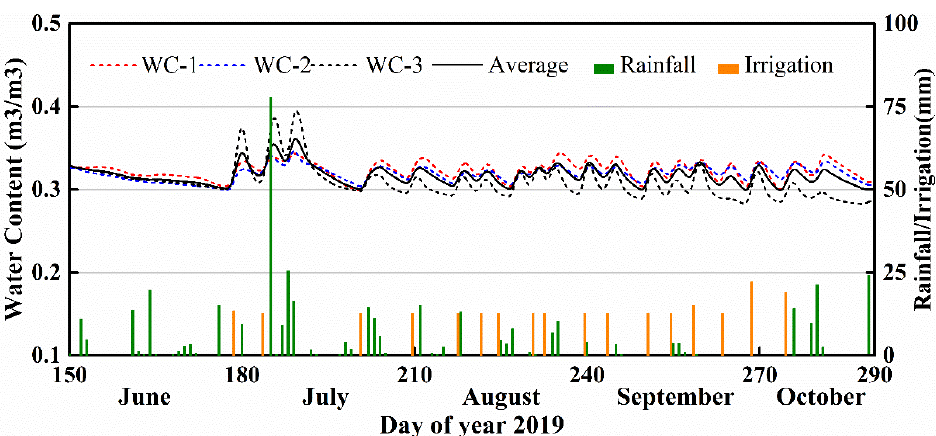
Figure 4. Illustration of daily irrigation, rainfall events and soil water content at different depth of the ground.